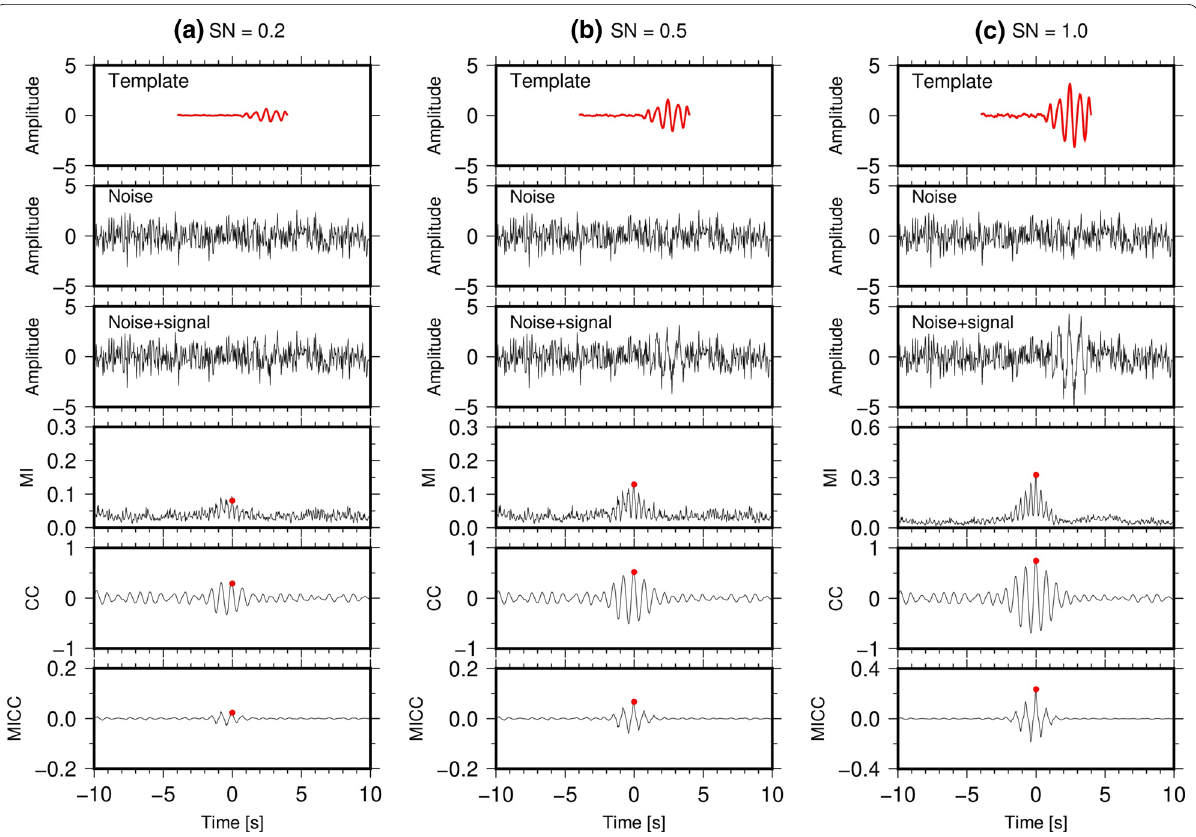
Fig. 3 MI, CC, and MICC for a signal comprising the template waveform with added Gaussian noise. The indices are calculated for each time step with the moving time window. The SN ratios are ( a ) 0.2, ( b ) 0.5, and ( c ) 1.0. Red dots show the index corresponding to the template